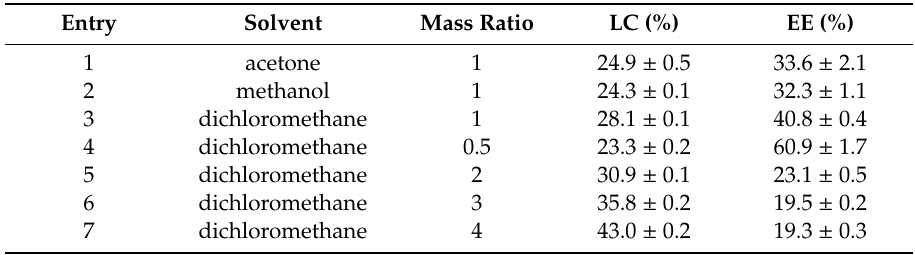
Table 2. Loading content (LC) and encapsulation e ffi ciency (EE) of diniconazole in NH 2 -Fe-MIL-101 with di ff erent solvents and mass ratios of pesticide to carrier a.